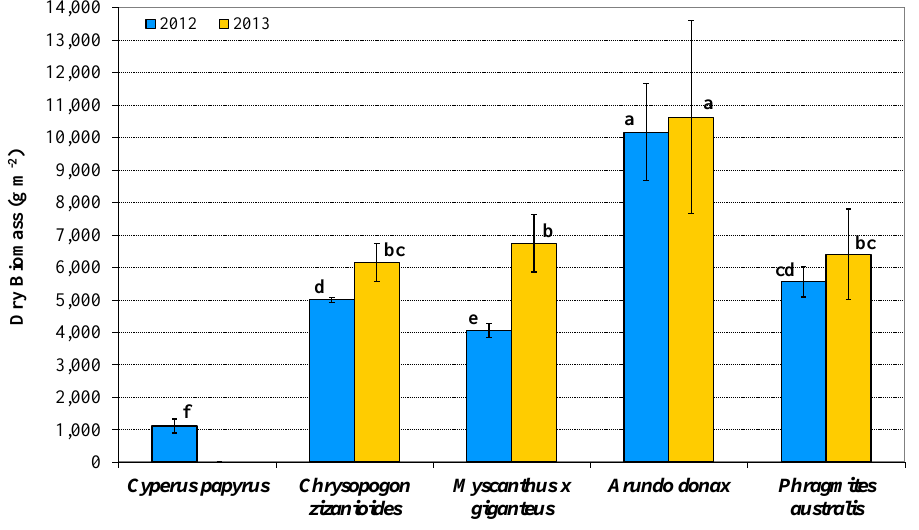
Figure 4. Total aerial dry matter of the herbaceous species in December 2012 and 2013 (different letters indicate significant differences at p < 0.05).